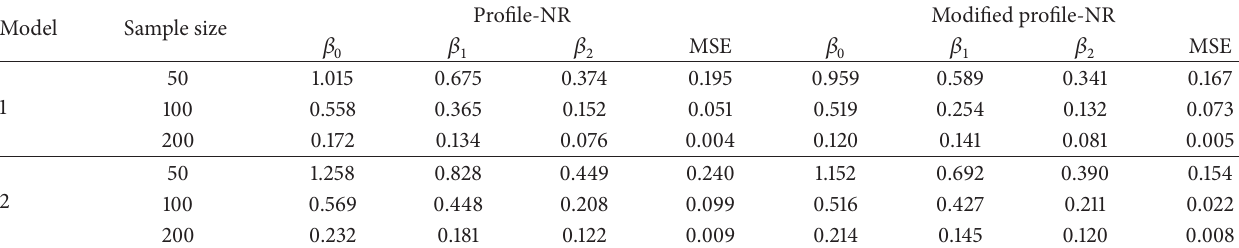
Table 2: The table shows the length of 95% confidence interval of parameters of interest and MSE of specified model.